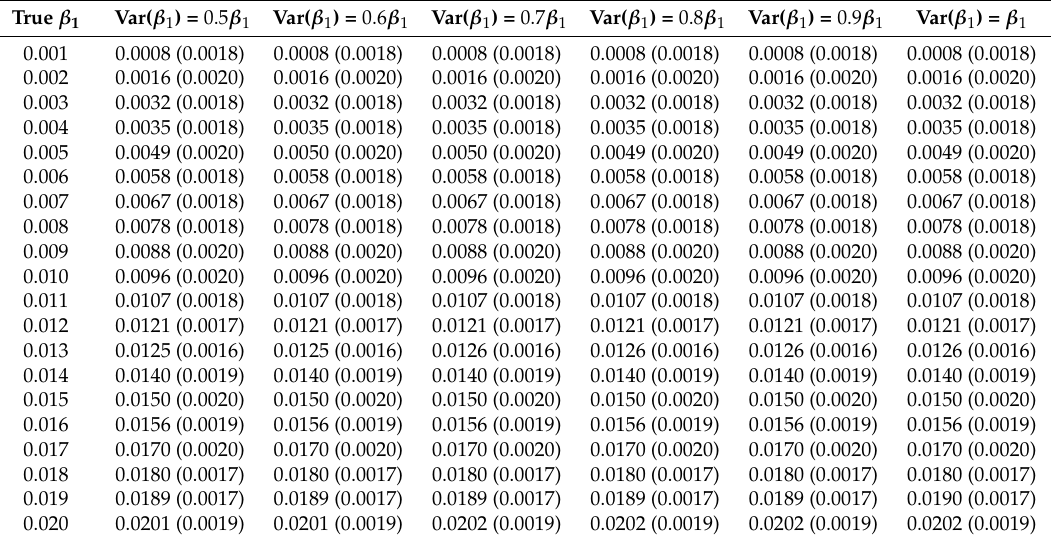
Table 6. Mean (SD) of estimated (cid:98) β 1 s derived from Bayesian GAMs of different true β 1 s. True β